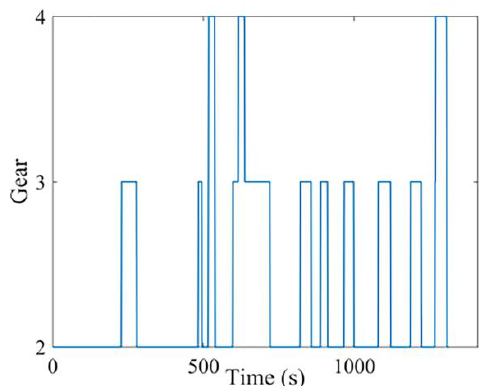
Figure 21. Gear of the EC shift schedule.